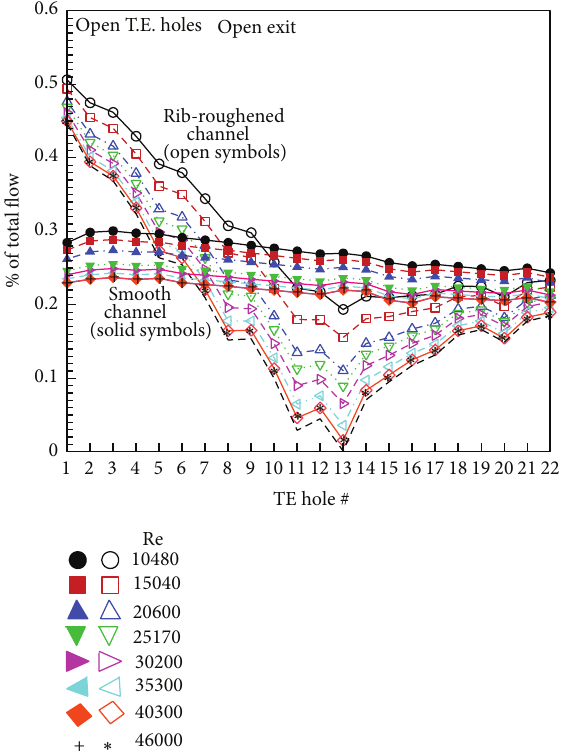
Figure 5: Percentage of mass flow rate through the trailing-edge holes in the smooth and rib-roughened channels.